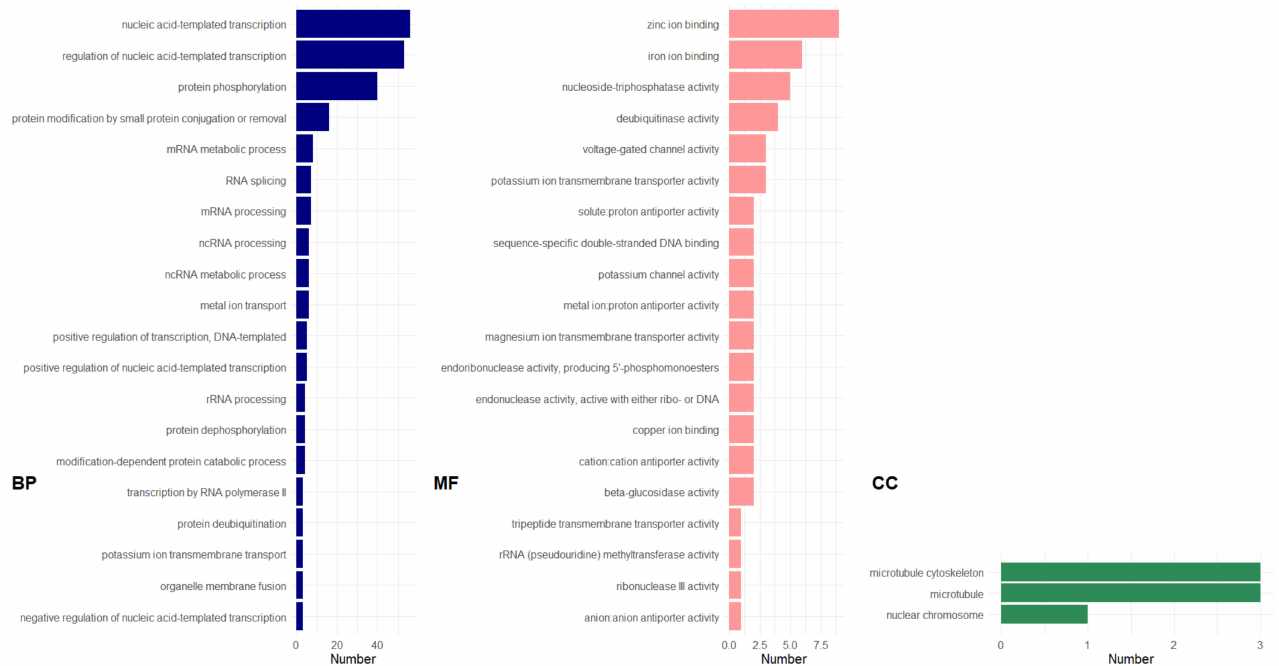
Figure 7. GO distribution of genes up-regulated in the abaca varieties but down-regulated in Pacol using GDE model for FQ. Legend similar to Figure 6. Figure generated using ggplot2 [57] in Rstudio [21]. GO distribution analyzed using OmicsBox